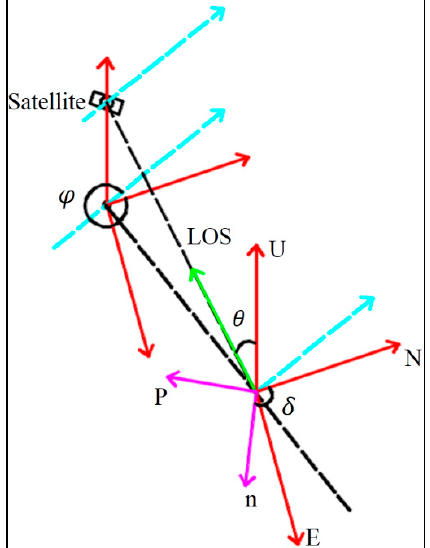
Figure 4. Schematic diagram of LOS decomposition. The red arrow represents the local east, north, up (ENU) coordinates; the blue arrow represents the flight direction of the satellite; the green arrow indicates the LOS direction; ϕ and θ are the azimuth and incident angle of the satellite, respectively; δ is the azimuth angle of a predefined direction; n and p directions are defined local coordinate systems.